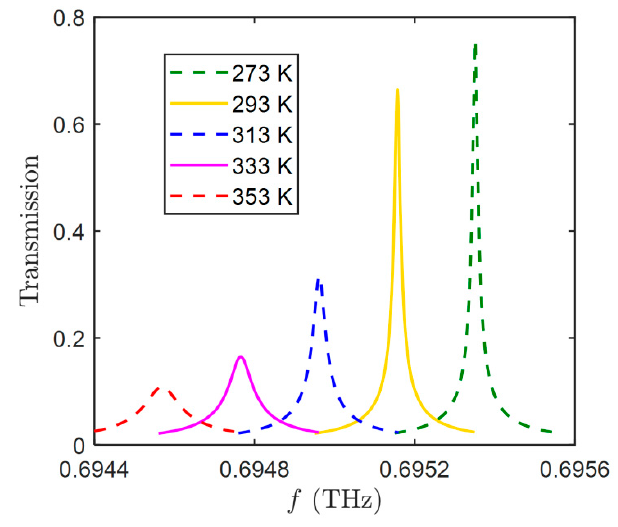
Figure 3. Frequency shifts of the NBDS when the temperature is increased from 273 K to 353 K.